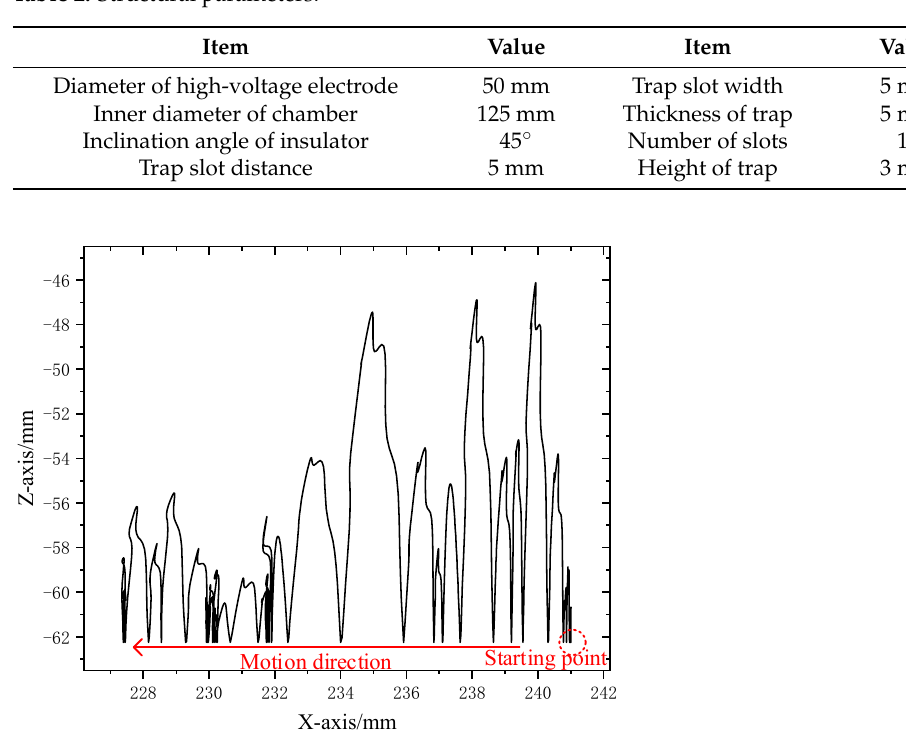
Figure 4. Simulation flow chart. Table 2. Structural parameters.